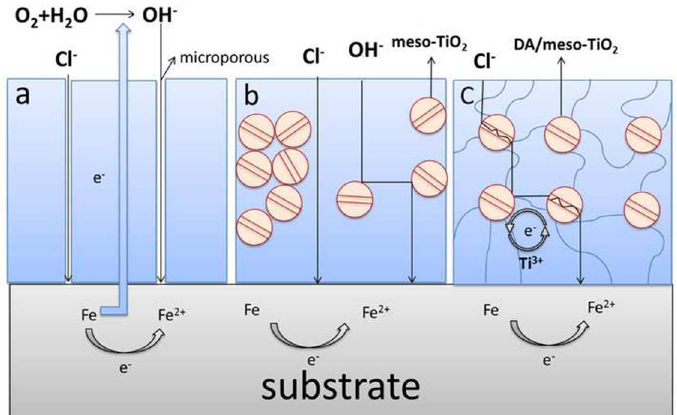
Figure 10. The simulation of anticorrosion mechanism: ( a ) neat waterborne epoxy coating; ( b ) waterborne epoxy coating containing meso-TiO 2 ; and ( c ) waterborne epoxy coating containing DA/meso-TiO 2 .